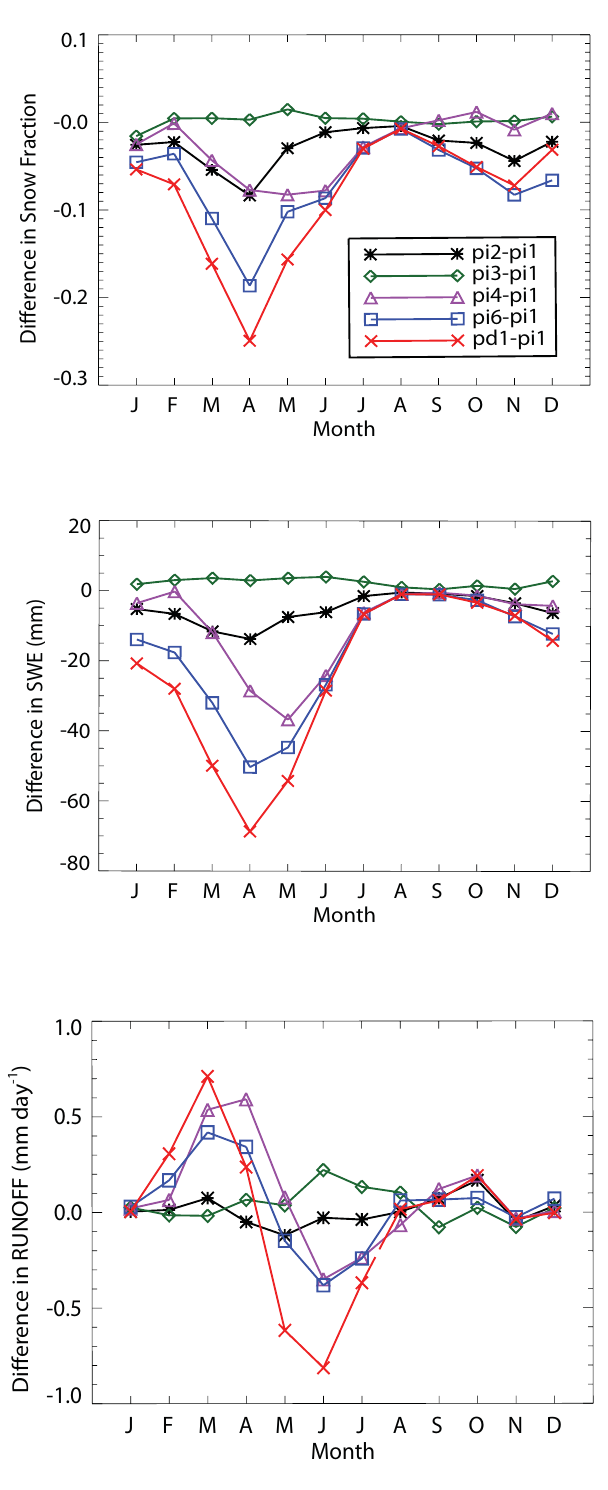
Fig. 11. Same as Fig. 9 but for snow cover fraction (top), snow water equivalence (SWE) (middle, Unit: mm) and runoff (bottom, Unit: mm day − 1 )